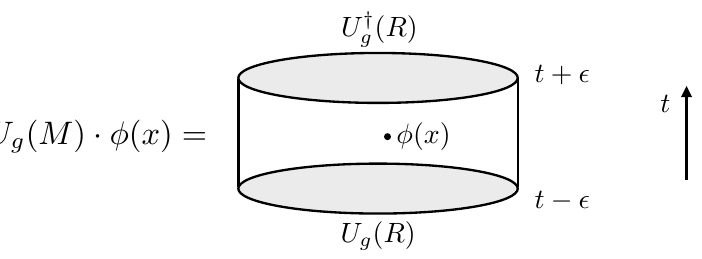
Figure 8 . The action of a topological defect on a local operator U g ( M ) · φ ( x ) . Here R is a disk in space and the closed manifold M , which has topology of a sphere, is the boundary of R × [ t − (cid:15), t + (cid:15) ]